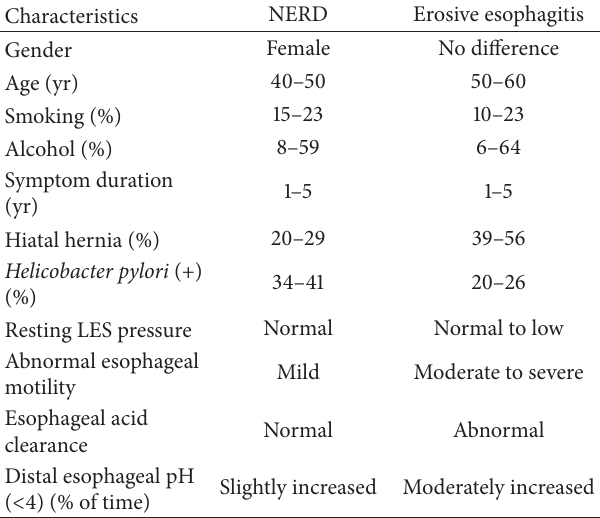
Table 2: Clinical and physiological characteristics between patients with NERD and erosive